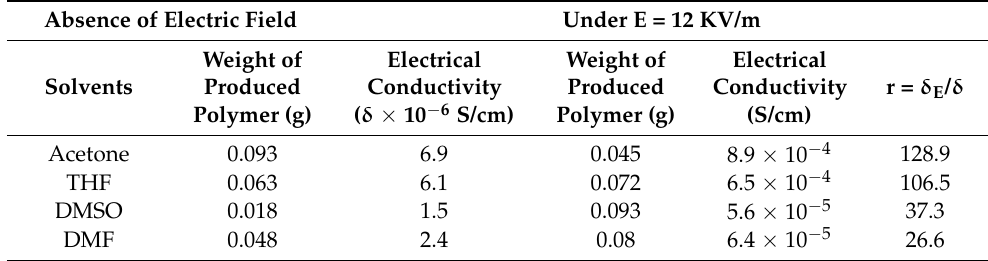
Table 3. Electrical conductivity of polycarbazole produced with FeCl 3 (dry) and PTSA (1M) as the initiator and dopant (1/5 mol ratio) in different solvents, in the absence and presence of a 12 KV/m electric field after 3 h. Absence of Electric Field Under E = 12 KV/m Weight of